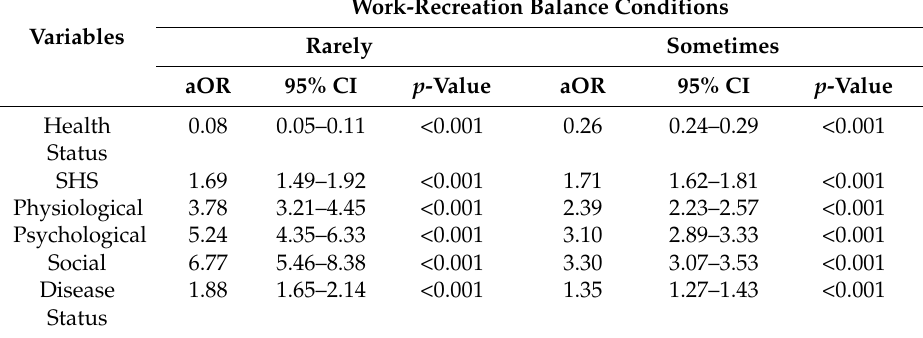
Table 5. Adjusted odds ratios (aORs) pertaining to work-recreation balance frequency and health status via multinomial logistic regression